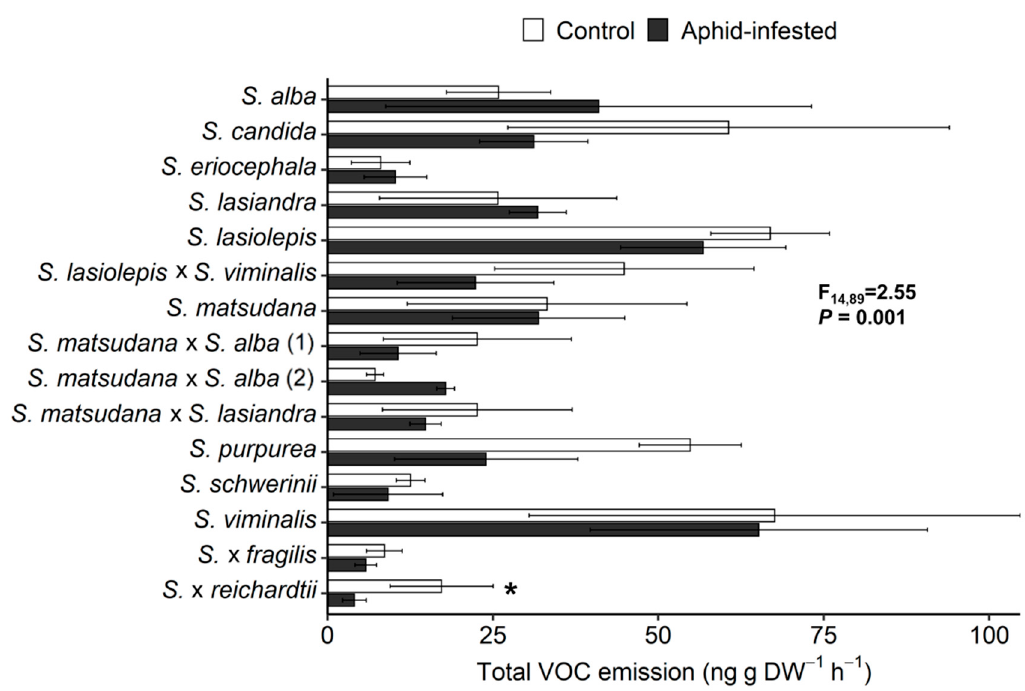
Figure 4. Total VOCs emitted by fifteen willow species and hybrids in the control and aphid-infested treatments. The values and error bars indicate means ± SE. Asterisks indicate significant differences between the treatments within a species/hybrid, Tukey’s HSD test, α = 0.05.